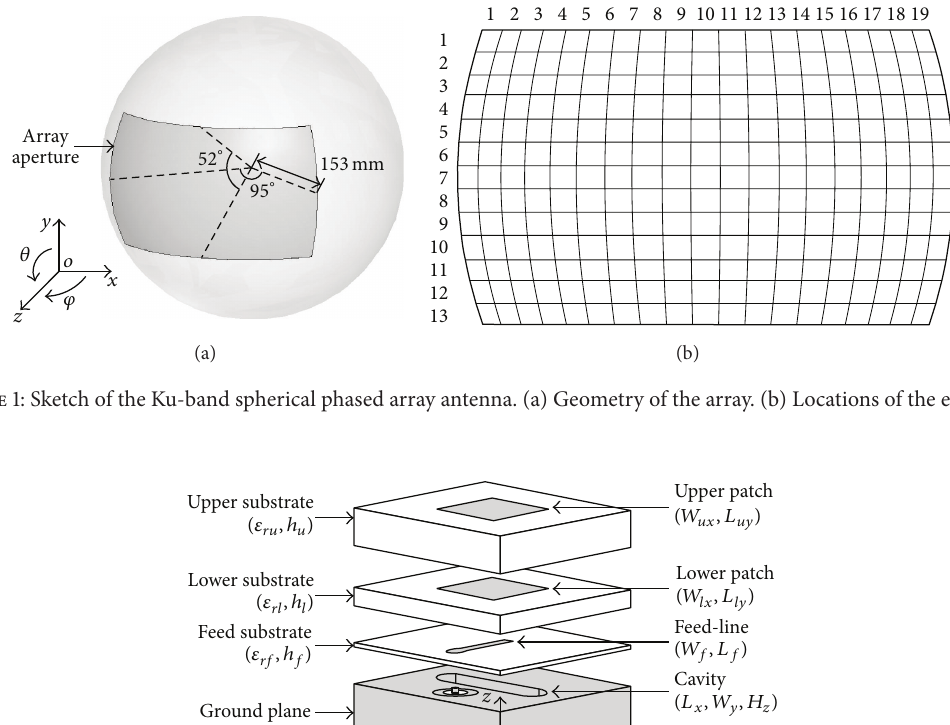
and 𝐿 𝑓 = 1.3 mm. The simulated results are revealed in Figure 3. The magnitude of the mutual coupling between the two elements is |𝑆 (𝑖,𝑗),(𝑚,𝑛) | , where 𝑖 and m as well as 𝑗 and 𝑛 are the row and the column numbers of the